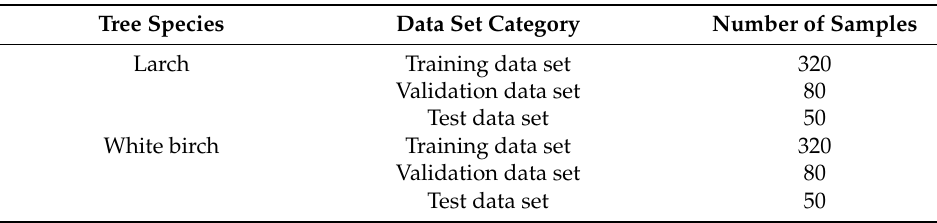
Table 3. Single tree sample attributes.